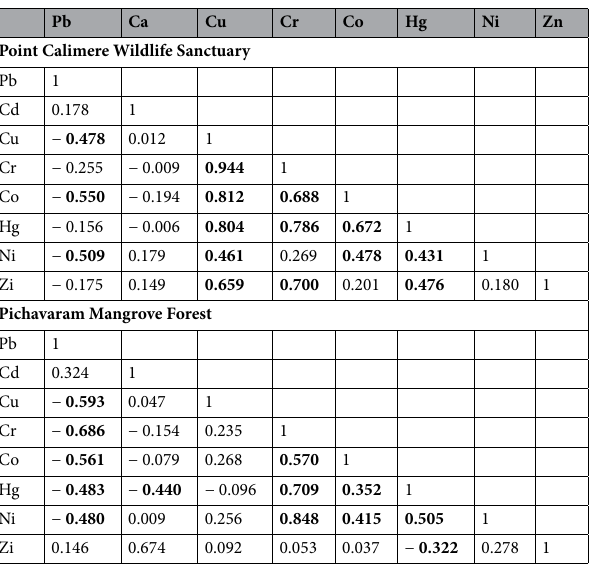
Table 3. Inter-correlational analysis of metals evaluated from the feathers of shorebirds, Point Calimere Wildlife Sanctuary and Pichavaram Mangrove Forest (Bold letter values are indicates significant differences at